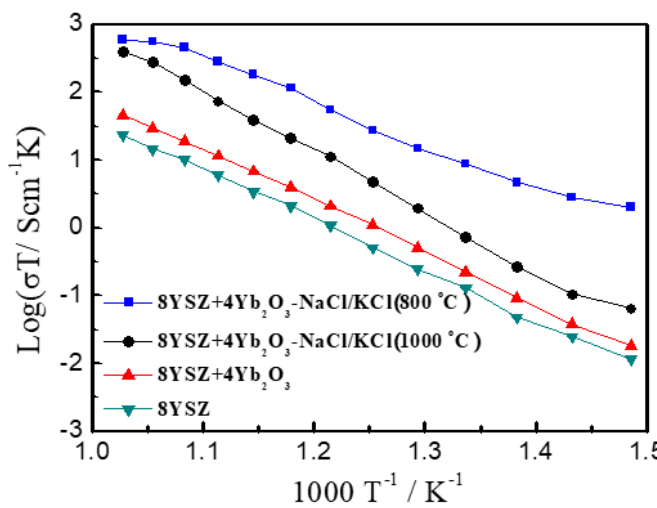
Figure 3. The log ( σ T)~1000 T − 1 plots of the 8YSZ, 8YSZ+4Yb 2 O 3 , 8YSZ+4Yb 2 O 3 -NaCl/KCl (800 °C), and 8YSZ+4Yb 2 O 3 -NaCl/KCl (1000 °C) pellets in air at 400–700 °C.